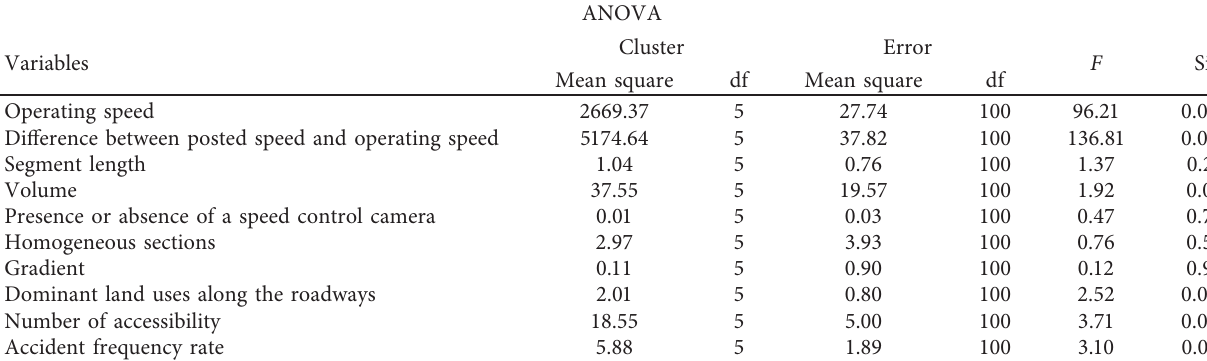
Table 4: Examination of the ANOVA test of variables in the clusters.